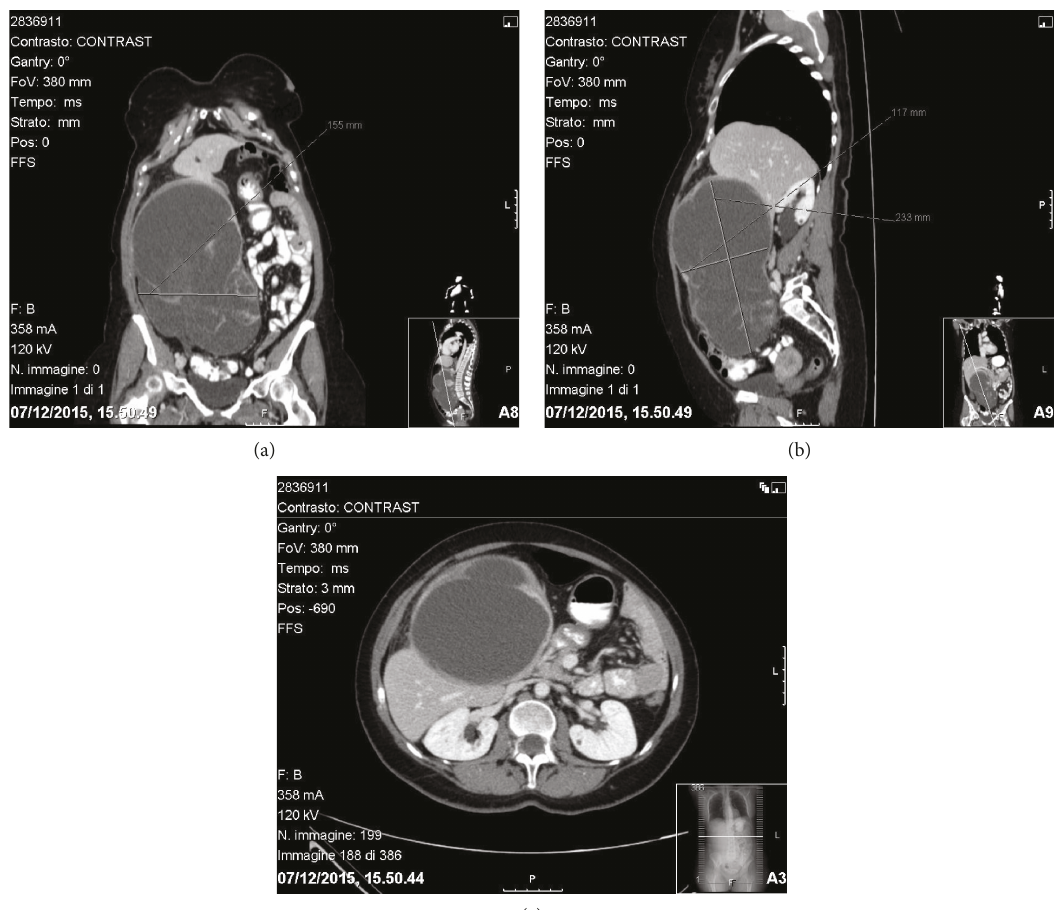
Figure 1: (a, b, c) A huge, partially cystic mass with heterogeneous contrast enhancement is seen in the right abdominal quadrant, adjacent to the liver (CT scan).